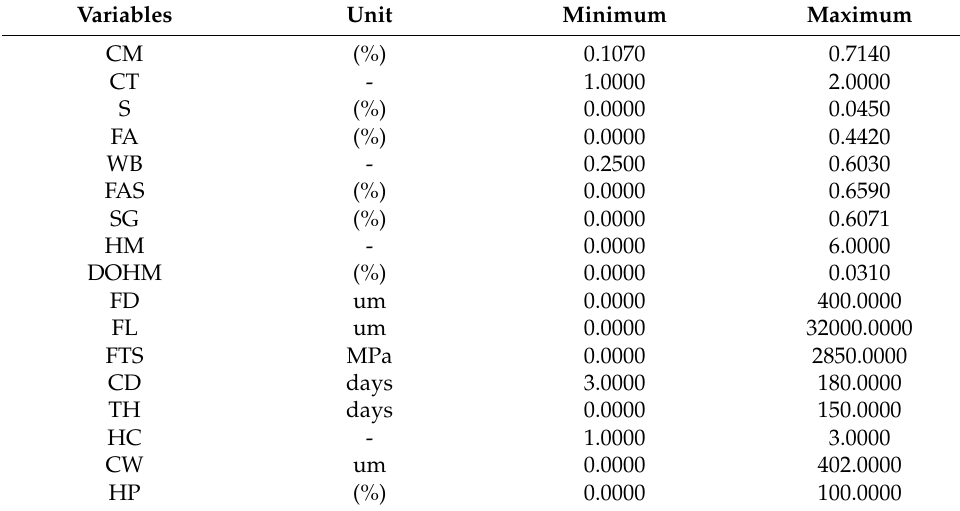
Table 3. The range of the 16 inputs and the